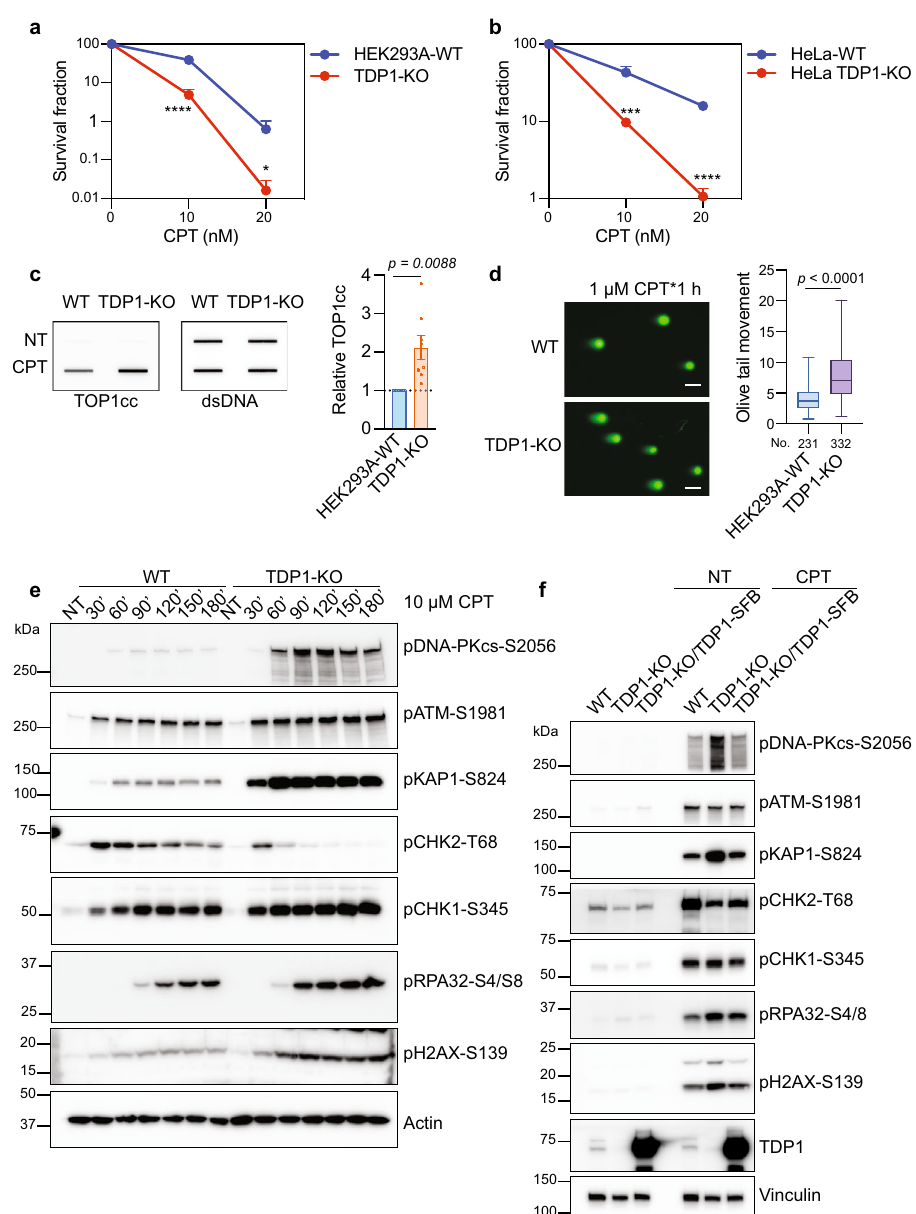
Fig. 1 TDP1-KO cells show increased DSB formation and DSB-induced DNA damage response after treatment with TOP1 poison. a Colony formation assay of HEK293A-WT and TDP1-KO cells with CPT treatment. Data are represented as mean ± SD. n = 6 biologically independent replicates. Two-tailed unpaired t test with Welch ’ s correction was used for statistical analysis. **** p (10 nM CPT) = 0.000003 and * p (20 nM CPT) = 0.013413. b Colony formation assay of HeLa-WT and HeLa TDP1-KO cells with CPT treatment. Data are represented as mean ± SD. n = 6 biologically independent replicates. Two-tailed unpaired t test with Welch ’ s correction was used for statistical analysis. *** p (10 nM CPT) = 0.000121, and **** p (20 nM CPT) = 0.000003. c RADAR assay showed increased TOP1cc accumulation in TDP1-KO cells. WT and TDP1-KO cells were either not treated (NT) or treated with 10 μ M CPT for 1 h. Double-stranded DNA (dsDNA) is used as a loading control. Data are represented as mean ± SEM. n = 8 biologically independent replicates. Two- tailed unpaired t test with Welch ’ s correction was used for statistical analysis. d TDP1-KO cells displayed increased DSBs when compared to WT cells after CPT treatment. Representative results of the neutral comet assay were shown (scale bar, 50 µ m). Olive tail movement was measured by open comet software and plotted as a box plot. The center line indicates the median, the box bounds indicate the fi rst and third quartiles, and the whiskers indicated the maximum and minimum. Numbers (No.) of cells examined were indicated. Two-tailed unpaired t test with Welch ’ s correction was used for statistical analysis. e WT and TDP1-KO cells were treated with 10 µ M CPT for the indicated times. Whole-cell extracts were prepared and subjected to Western blotting with the indicated antibodies. Experiments were repeated at least three times, and similar results were obtained. f WT, TDP1-KO, and TDP1-KO/ TDP1-SFB cells were not treated (NT) or treated with 10 µ M CPT for 1 h. Whole-cell extracts were prepared and subjected to Western blotting with the indicated antibodies. Experiments were repeated at least three times, and similar results were